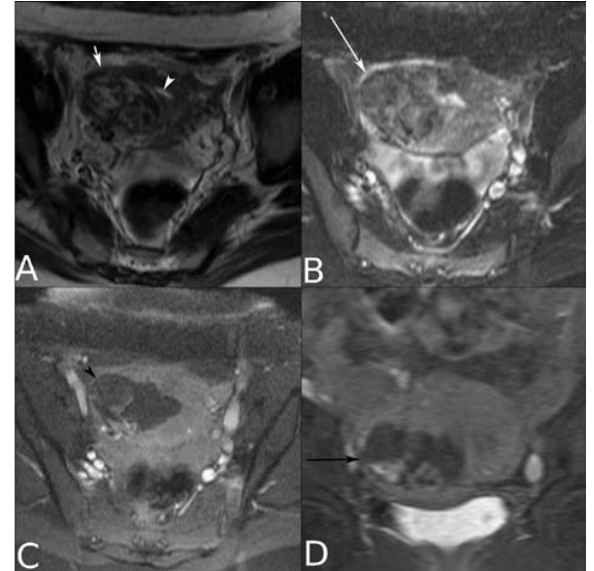
Figure 1. Fig 1A and B show a mixed intensity lesion extending from the endometrial cavity (arrow head in A) through the myometrium to the serosal surface of the uterus (short white arrow in A and long white arrow in B). After enhancement by I/V gadolinium, the lesion shows decreased enhancement compared to the myometrium (C and